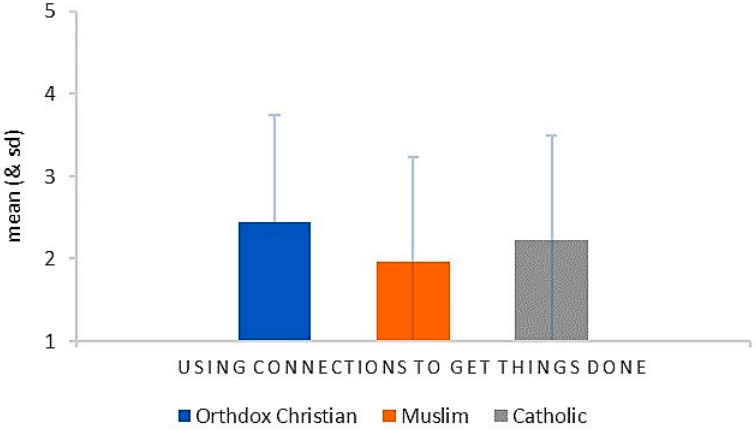
Figure 8. Using connections to get things done. (The error bars represent standard deviation).